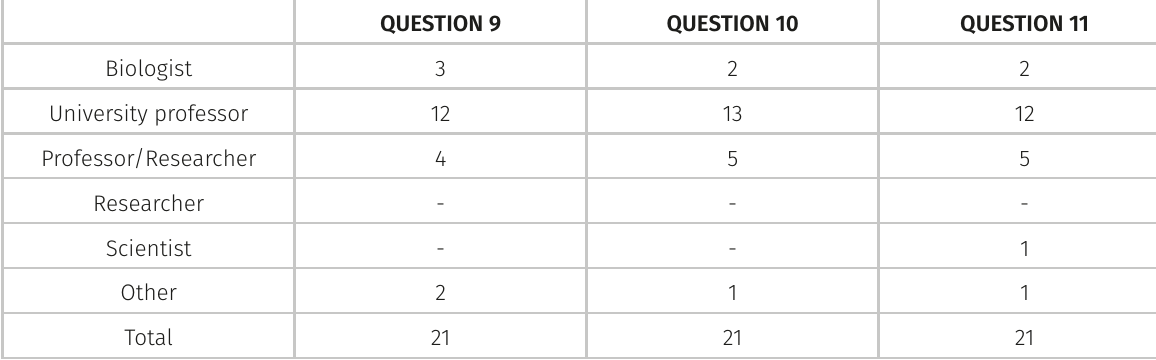
Table III. Frequency of answers for three questions of informal